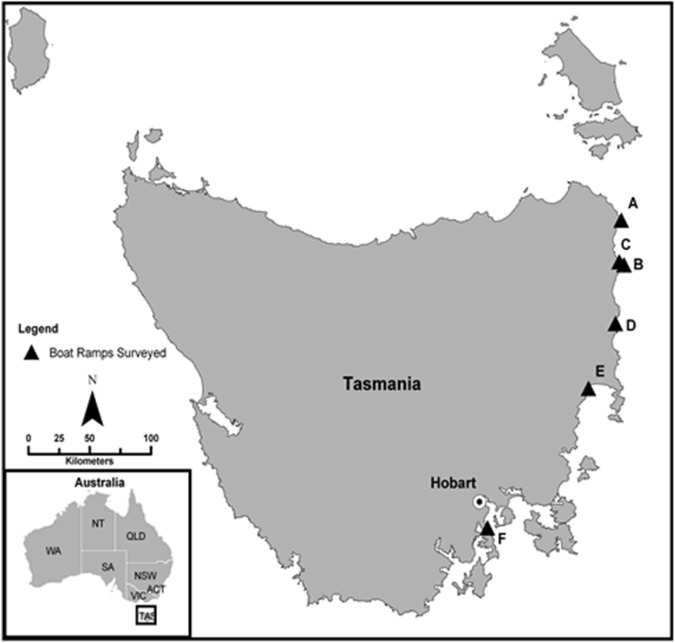
Map of the six boat ramps used for surveys on the east coast of Tasmania.Where A = Eddystone point (-40°59’ 24.07 S, 148°20’44.41 E), B = Binnalong Bay (-41°20’23.51”S, 148°16’15.39”E), C = St Helens (-41°16’ 37.40”S, 148°20’55.96”E), D = Bicheno (-41°55’28.07”S, 148°18’14.04”E), E = Triabunna (-42°30’18.33”S, 147°54’28.97”E), F = Tinderbox (-43°03’31.93”S, 147°19’48.68”E).